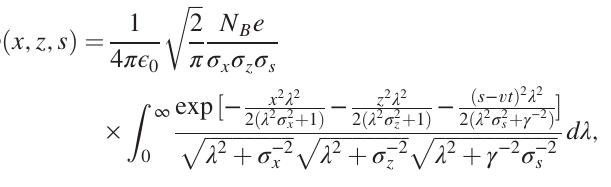
p d λ p ffiffiffiffiffiffiffiffiffiffiffiffiffiffiffiffiffiffiffiffiffiffiffi ffiffiffiffiffiffiffiffiffiffiffiffiffiffiffiffiffi λ 2 þ γ − 2 σ − 2 λ 2 þ σ − 2 z s